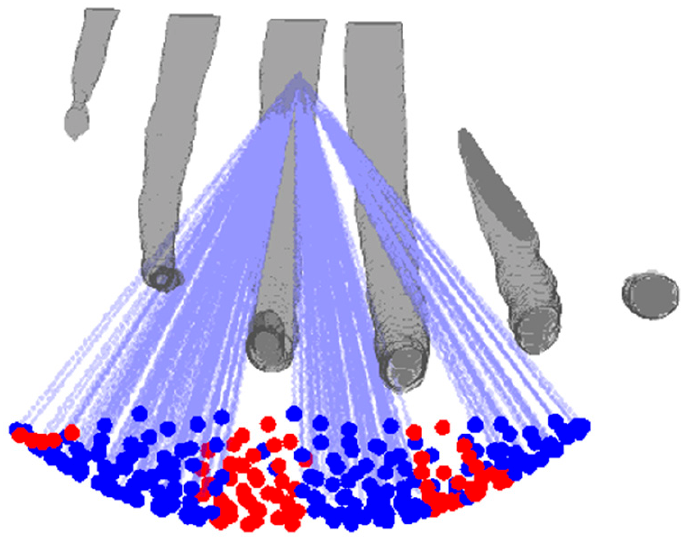
Figure 3. Configuration of the anatomical ribs with respect to the array. Rays are traced from the array elements to the focus, and the elements blocked by the ribs are deactivated and shown in red.